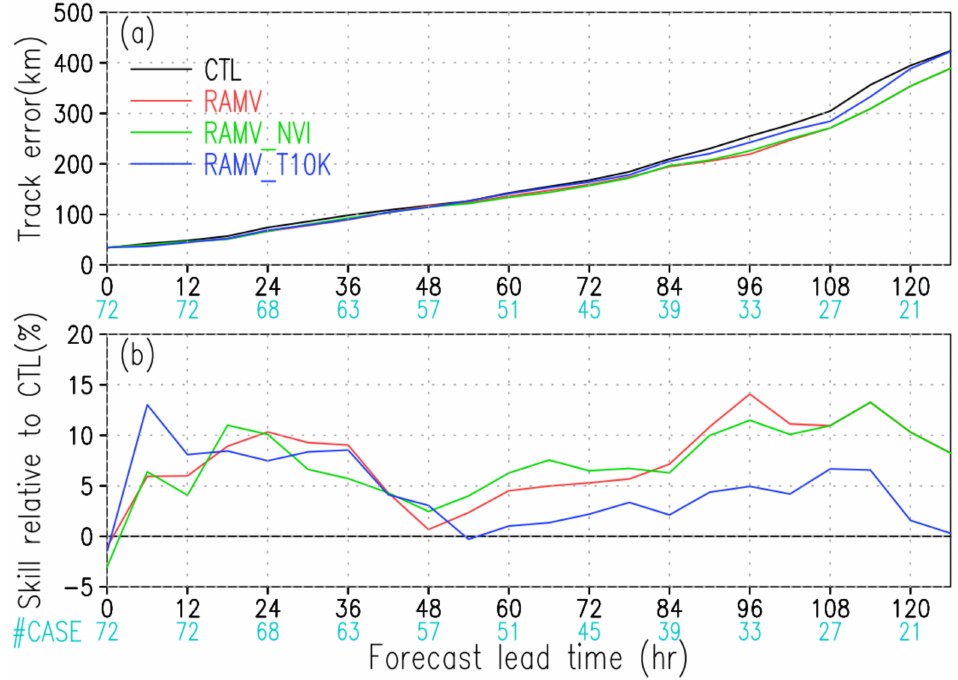
Figure 2. Statistics of ( a ) track error with reference to the best track data and ( b ) track forecast skill relative to CTL for all cases. Numbers in cyan indicate sample size for each forecast lead